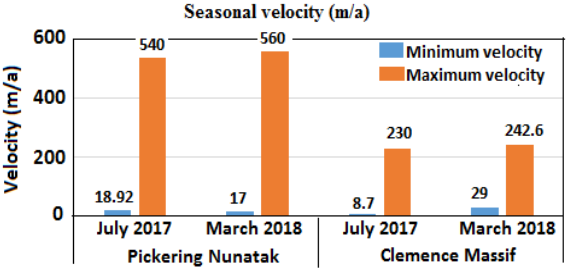
Figure 4. Histograms of maximum and minimum velocity during summer and winter of the eastern tributary glaciers.